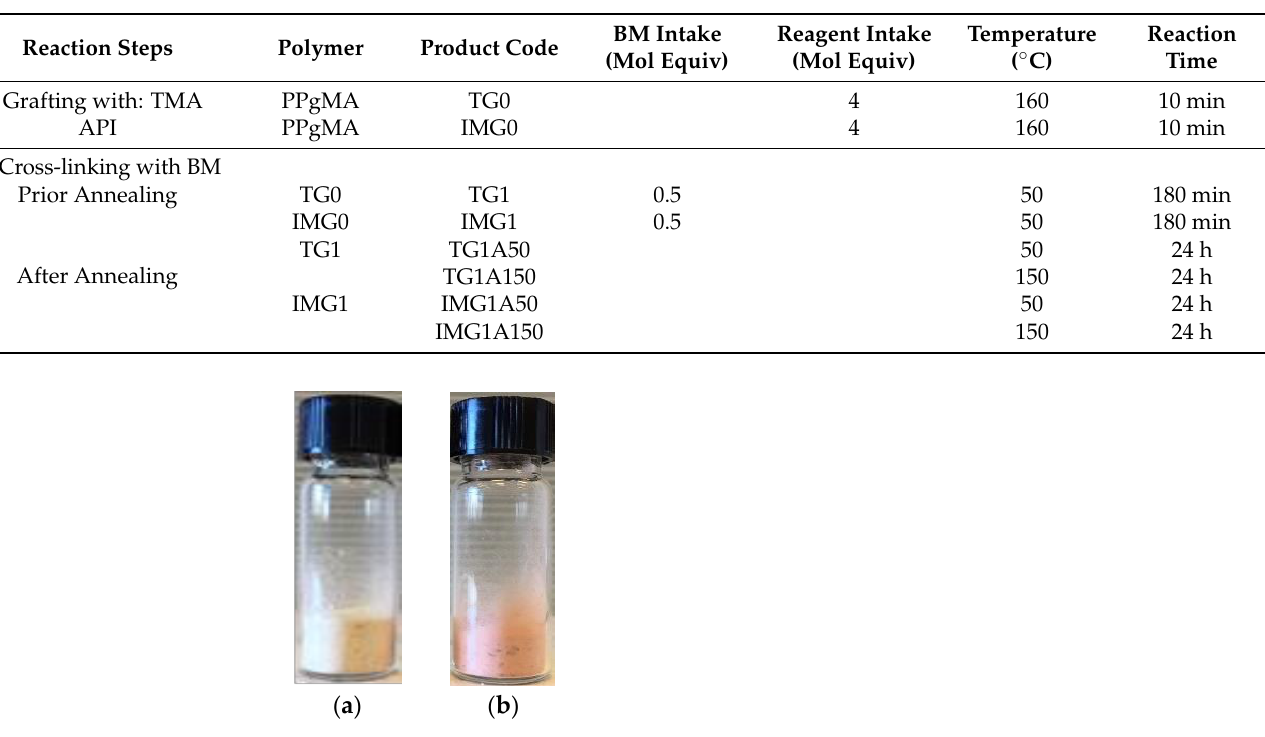
Table 1. Detailed experimental condition of grafting thiophene and imidazole and subsequent cross-linking with BM.